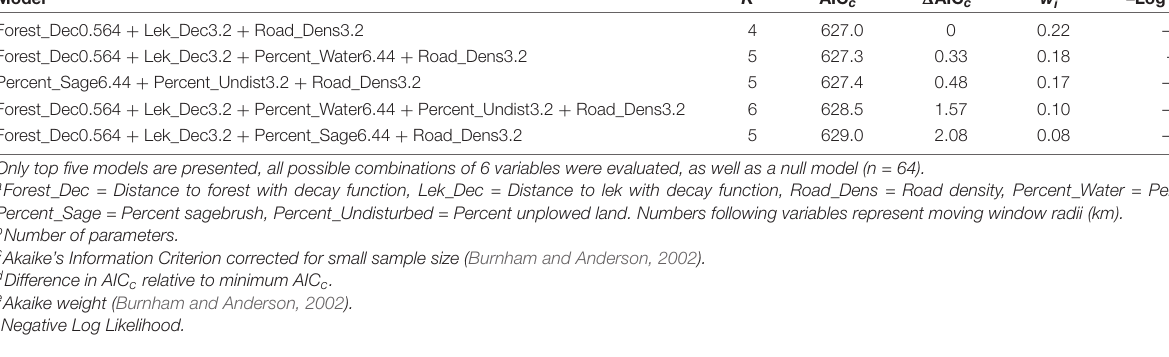
TABLE 6 | Models for nest-site resource selection function. Model a